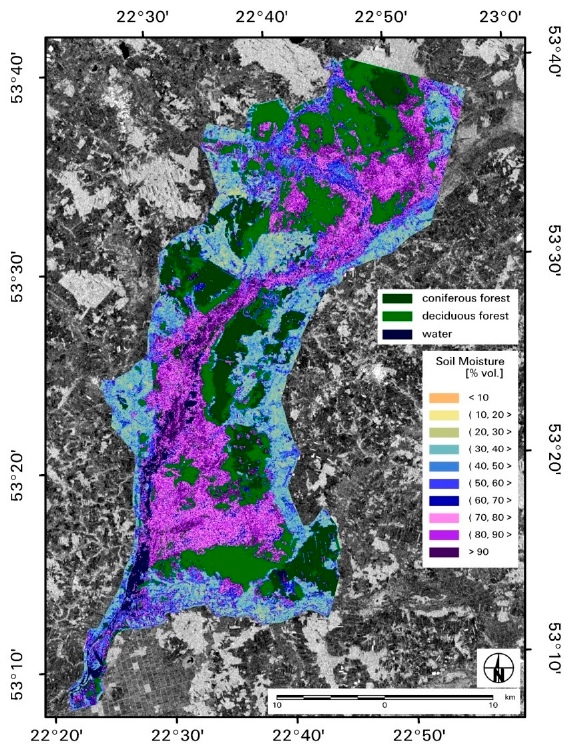
Figure 3. Map of soil moisture based on Sentinel-1 VH data acquired on 11 June 2015.